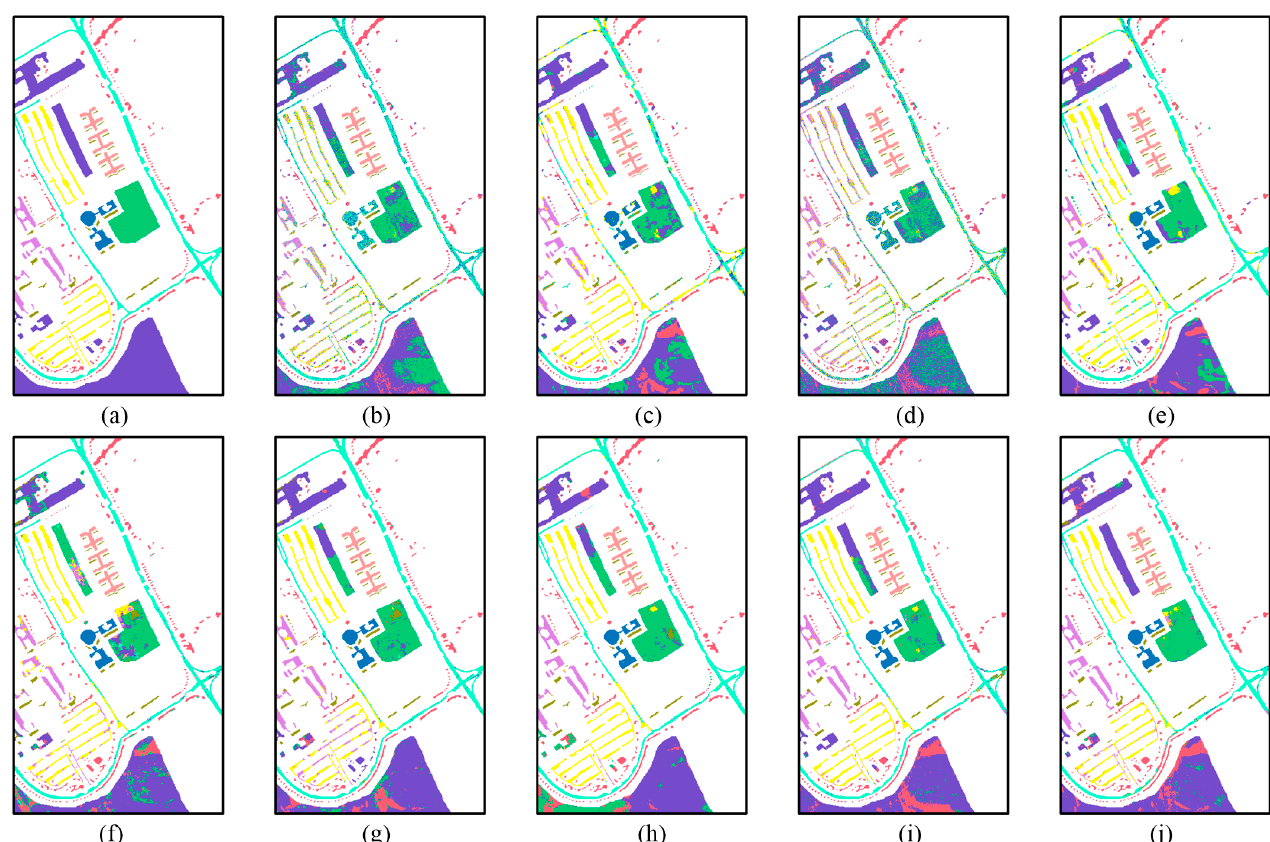
Figure 8. Ground truth and classification maps for the University of Pavia data set. ( a ) Ground truth. ( b ) KSRC. ( c ) MASR. ( d ) CRT. ( e ) KFRC ‐ CKIR. ( f) MF ‐ SRC. ( g ) MF ‐ JSRC. ( h ) MFASR. ( i ) MFCARC. ( j ) MFCART.